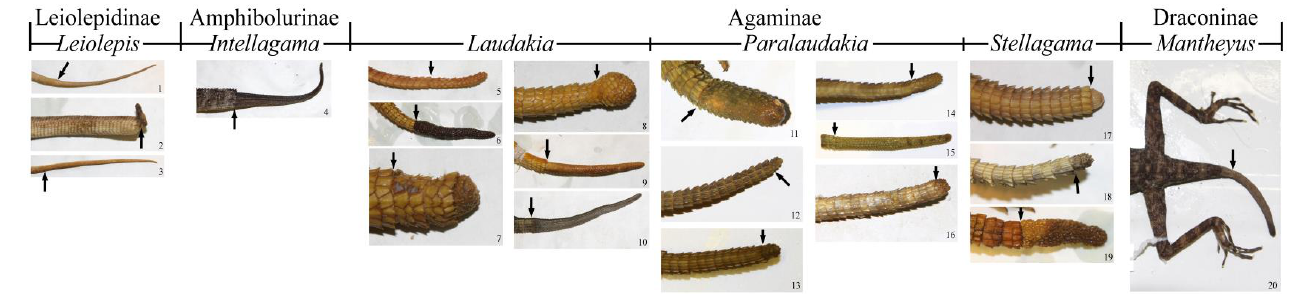
Figure 4. Different types of tail regenerates of agamid lizards of different subfamilies. 1. Leiolepis belliana (China, ZISP 17166); 2. Leiolepis guentherpetersi (Vietnam, ZISP 21877); 3. Leiolepis guttata (Vietnam, ZISP 20354); 4. Intellagama lesueurii